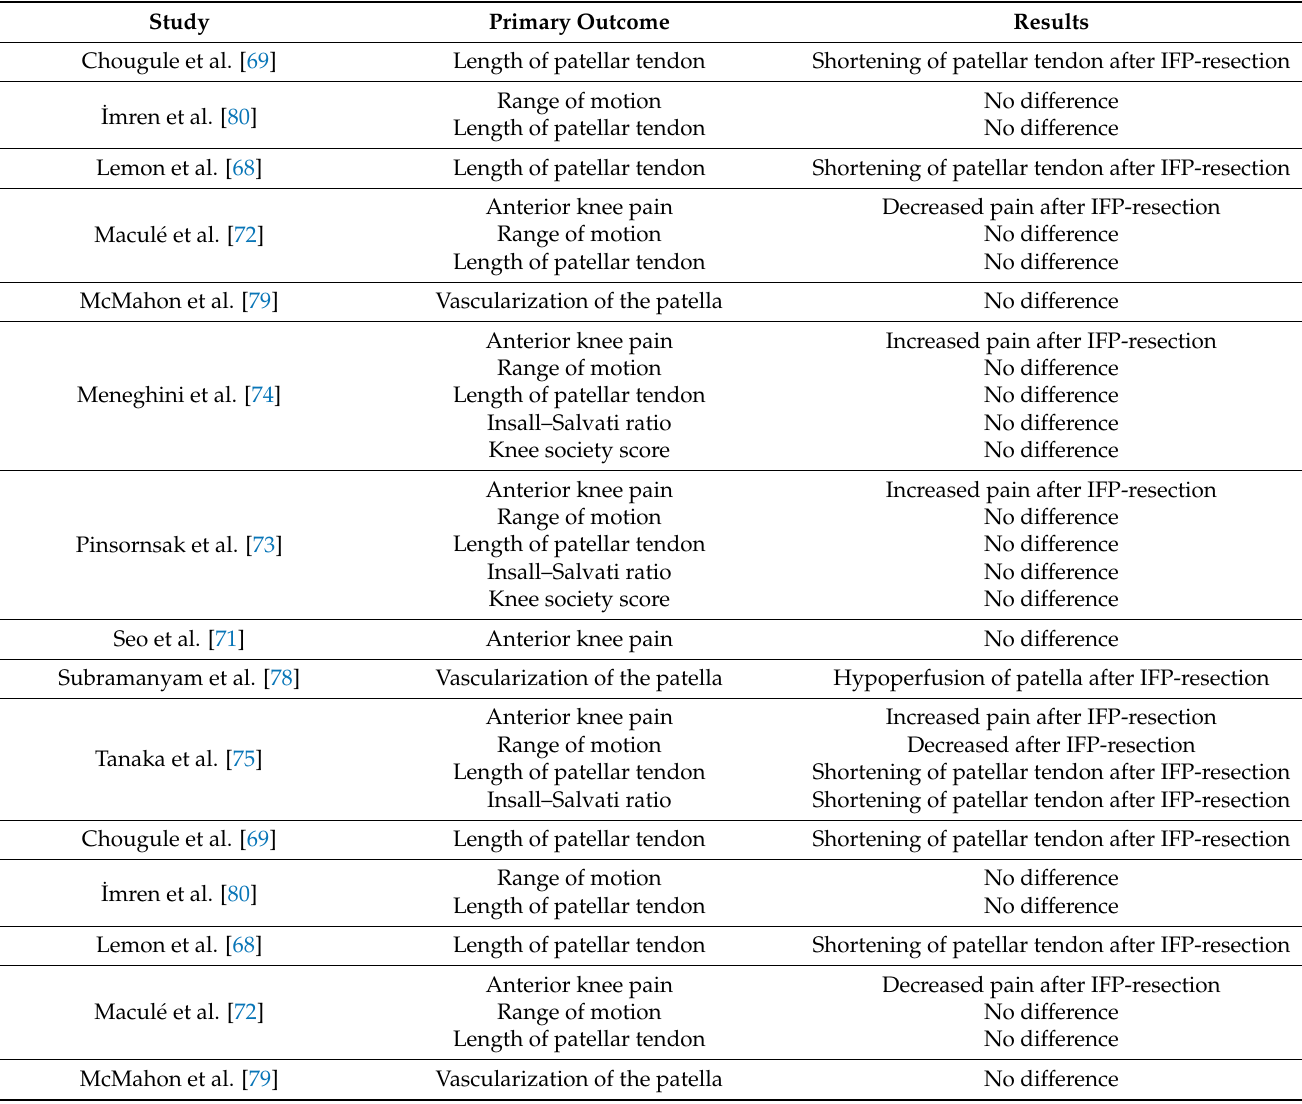
Table 3. Summary of the clinical consequences of IFP resection or preservation during TKA from the studies included for analysis in this